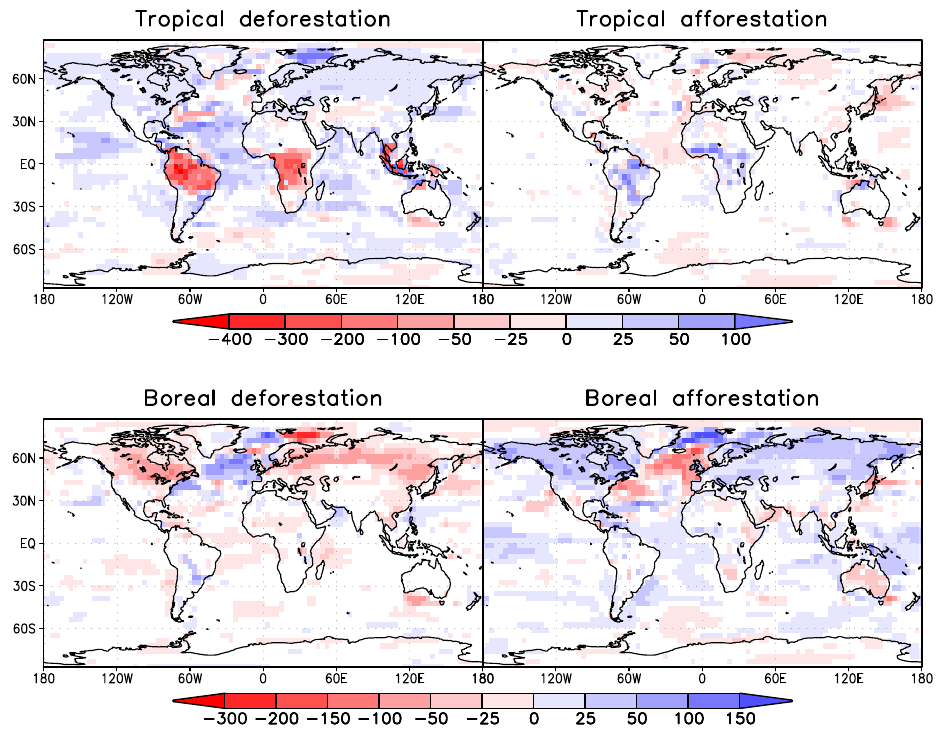
Fig. 8. ET anomalies in mm/year averaged over the final 200years for each experiment. White areas show no significant changes according to a t-test with 95%